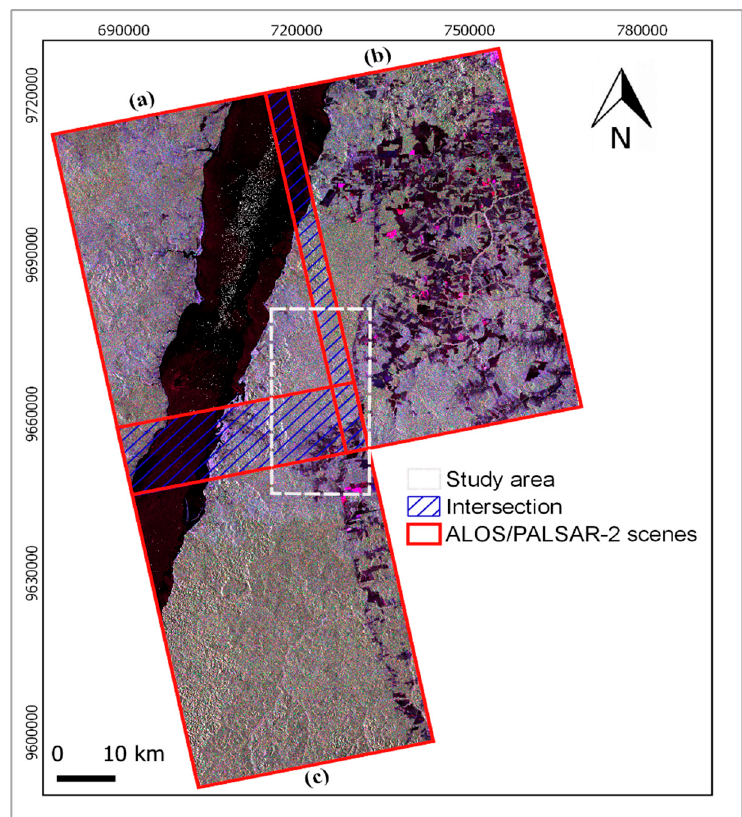
Figure 3. Mosaic of three ALOS/PALSAR-2 images covering the study area. The images were obtained on 1 May 2016 ( a , c ) and on 17 April 2016 ( b ). The mosaic corresponds to the RGB color composite of HH, HV, and VV polarizations. Table 2. Main characteristics of the ascending, full polarimetric ALOS/PALSAR-2 StripMap (SM2) acquisition mode images selected for this study.